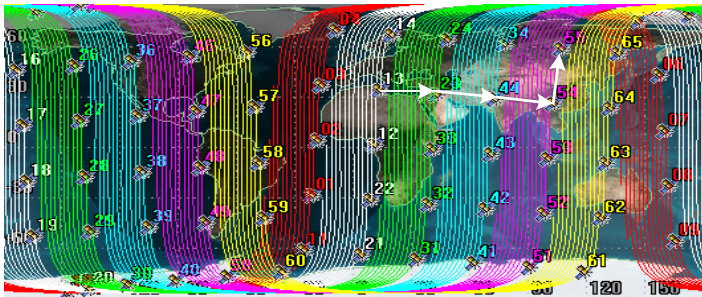
Figure 14. Multiple hop transmission.